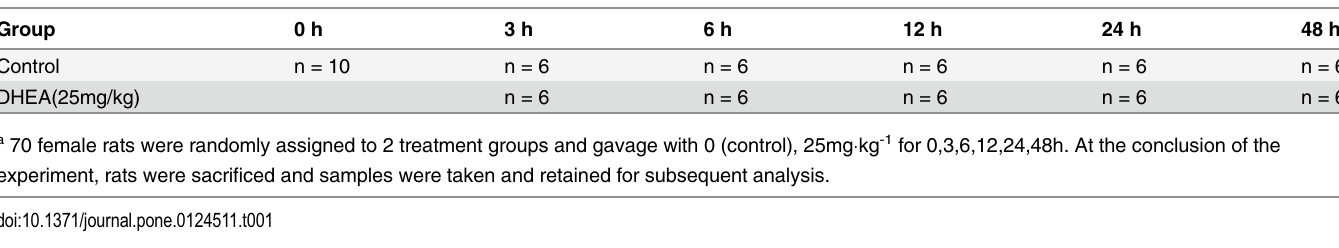
Table 1. Abbreviated experimental design.